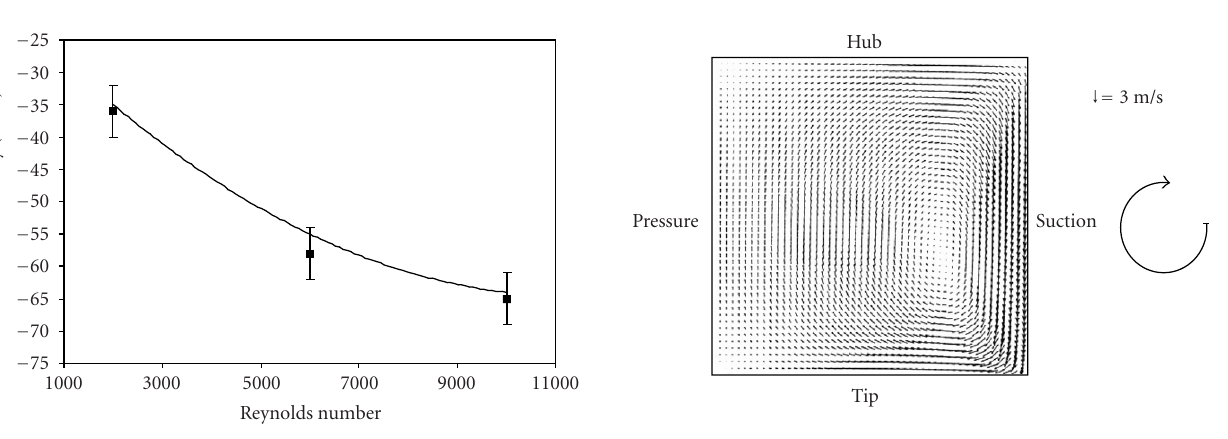
Figure 4: Predicted secondary flow field at impeller exit (Brun [34]).